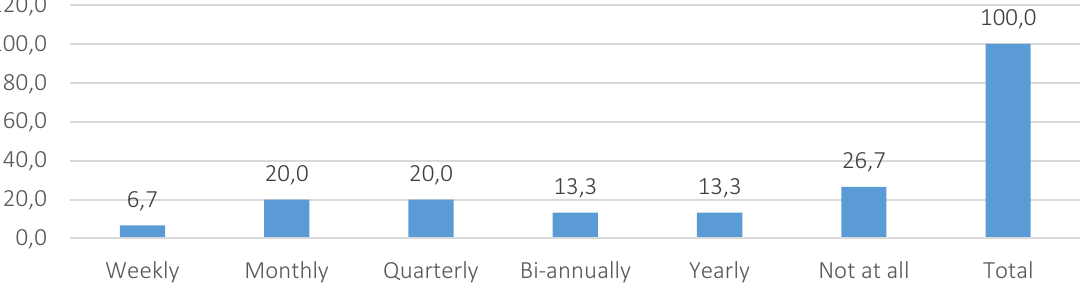
Figure 2. Frequency of institutional knowledge management